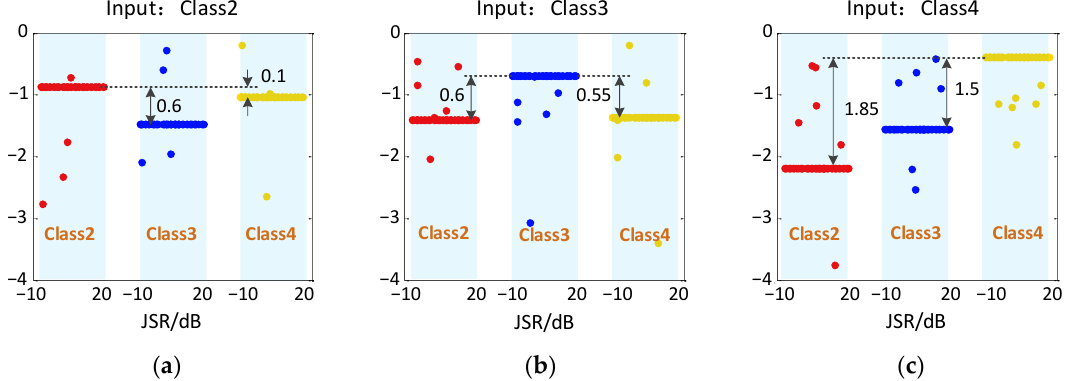
Class2, ( b ) Input is Class3, ( c ) Input is Class4.